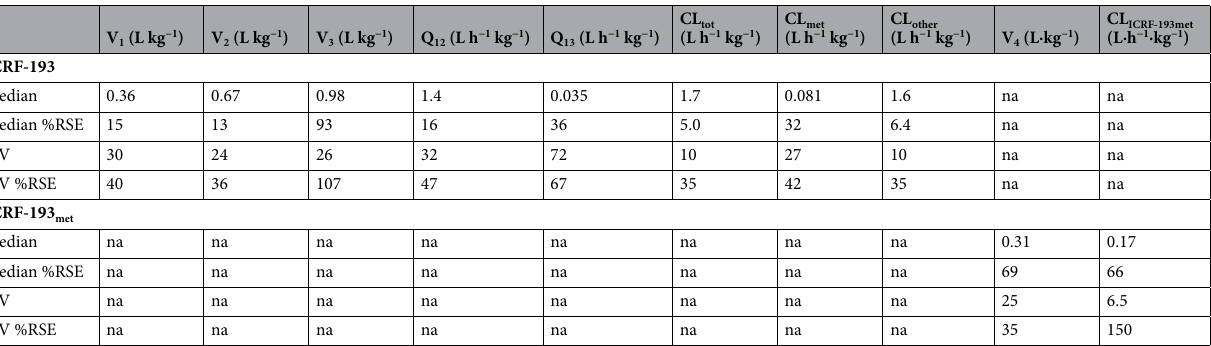
Table 2. Pharmacokinetic parameters of ICRF-193 and ICRF-193 met in rabbits determined by population analysis. V 1 , V 2 and V 3 distribution volumes of central and peripheral compartments for ICRF-193, V 4 distribution volume for ICRF-193 met , CL met formation clearance of ICRF-193 met from ICRF-193, CL other the sum of clearances of ICRF-193 via other elimination pathways than metabolism to ICRF-193 met , Q 12 and Q 13 inter- compartmental clearances, CL ICRF‑193met the total clearance of ICRF-193 met . The estimates of clearances and volumes of distribution were obtained assuming F = 1; ISV inter-subject variability expressed as the percent CV, na not applicable, %RSE percent relative standard